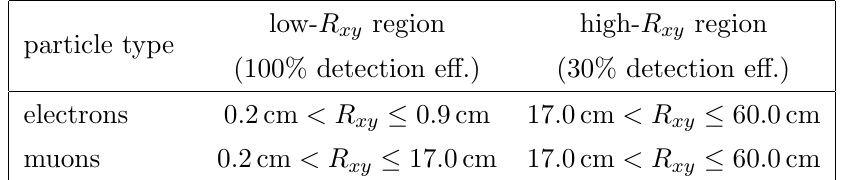
Table 3 . Regions and corresponding detection e(cid:14)ciencies used in the displaced analysis. R the distance between the z axis and the decay vertex in the plane perpendicular to the z axis.